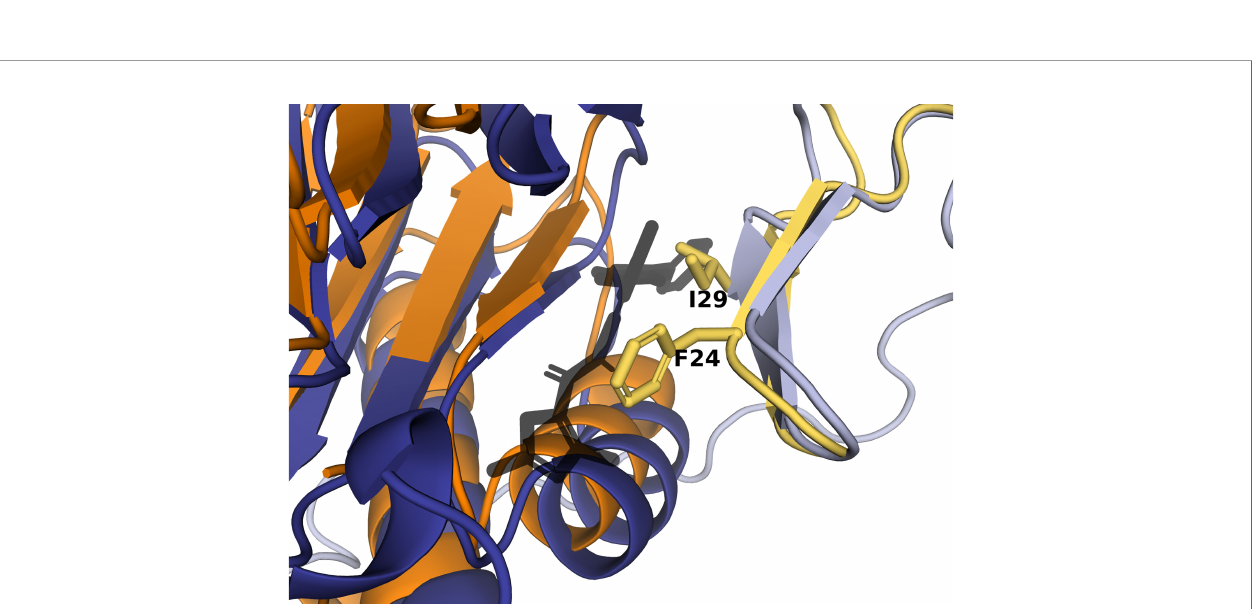
FIGURE 7 | T. cruzi proteasome b 2 and b 3 subunits superimposed with b 4 and b 5 subunits. The b 2 (light blue) and b 3 (dark blue) subunits were mapped unto the L. tarentolae corresponding proteasome subunits in PDB structure 6QM8. GNF6702 (dark shadow) binds with high af fi nity with subunit b 3. The b 4 (light orange) and b 5 (dark orange) subunits were superposed to the b 2 and b 3 subunits, respectively. The b 4 F24 and I29 residues, which are believed to play a role in GNF6702 sensitivity, are shown as